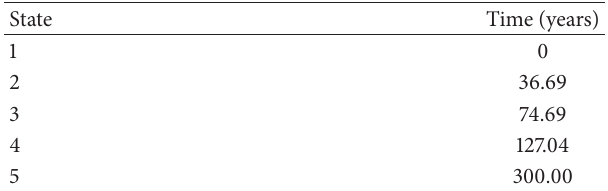
Table 4: Time at which the states change.